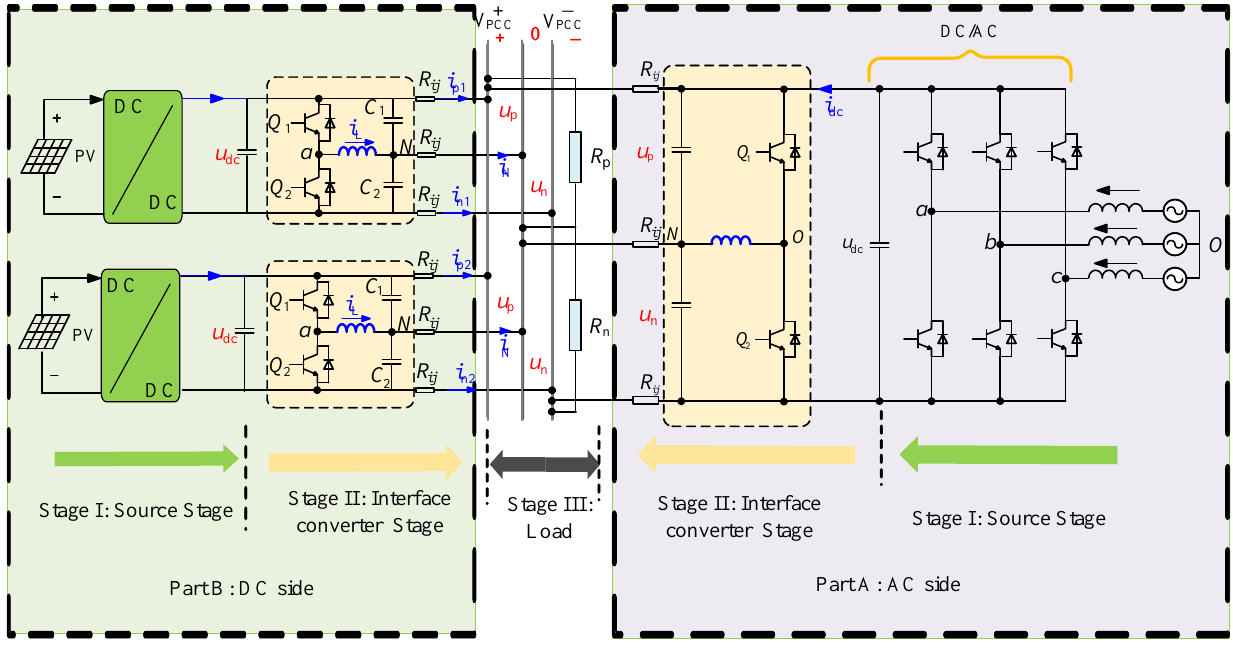
Figure 3. The system structure diagram of radial bipolar DC distribution with voltage balancers: (A) AC side and (B) DC side.